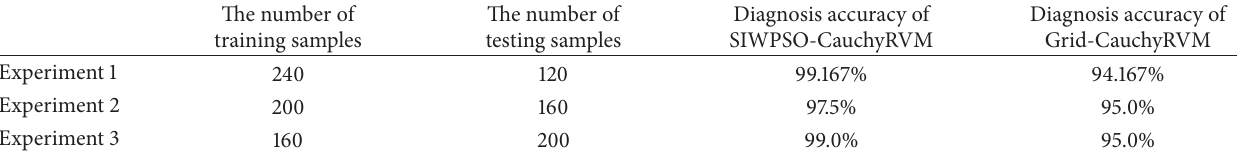
Table 1: The comparison of the diagnosis accuracies between SIWPSO-CauchyRVM and